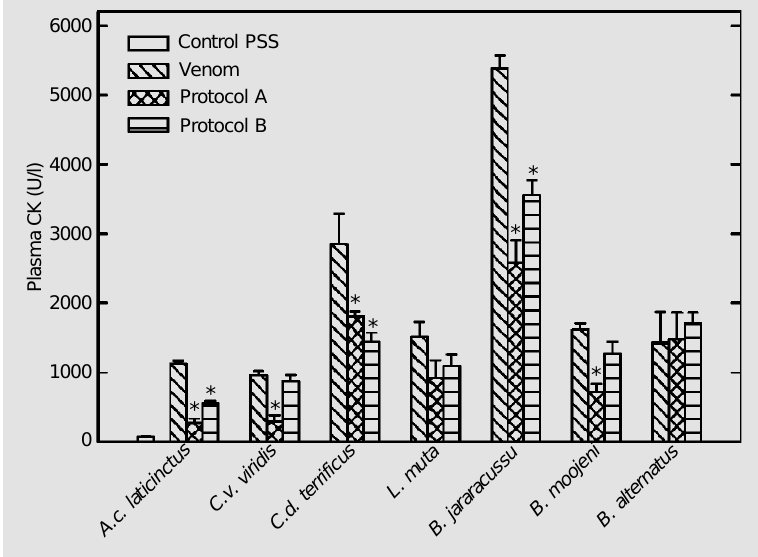
Figure 2. Effect of intramuscular injection of crotalid venoms on plasma creatine kinase (CK) activity and effect of treatment with suramin. Suramin (1.0 mg/kg) was administered according to two protocols: protocol A, preincubation in vitro with each venom; protocol B, 15 min iv administration of suramin after im injection of venom. Plasma CK activity of the physiological saline solution (PSS) control group was 71.16 ± 7.44 U/l (N = 5). The animals received the venom at the dose of 1 mg/kg, except for a group that received C.d. terrificus crude venom at the dose of 0.5 mg/kg. The values reported are means ± SEM. *P<0.05 for the difference between the control (venom alone) and the values for each of the two protocols for suramin treatment